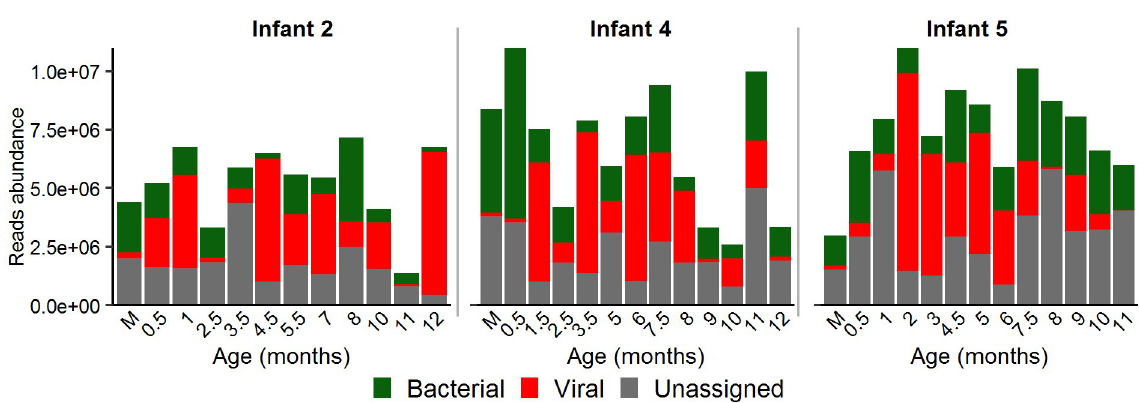
Fig 1. Abundance of bacterial and viral sequence reads in each sample. Samples from infants are indicated according to their age in months and from mothers as M.